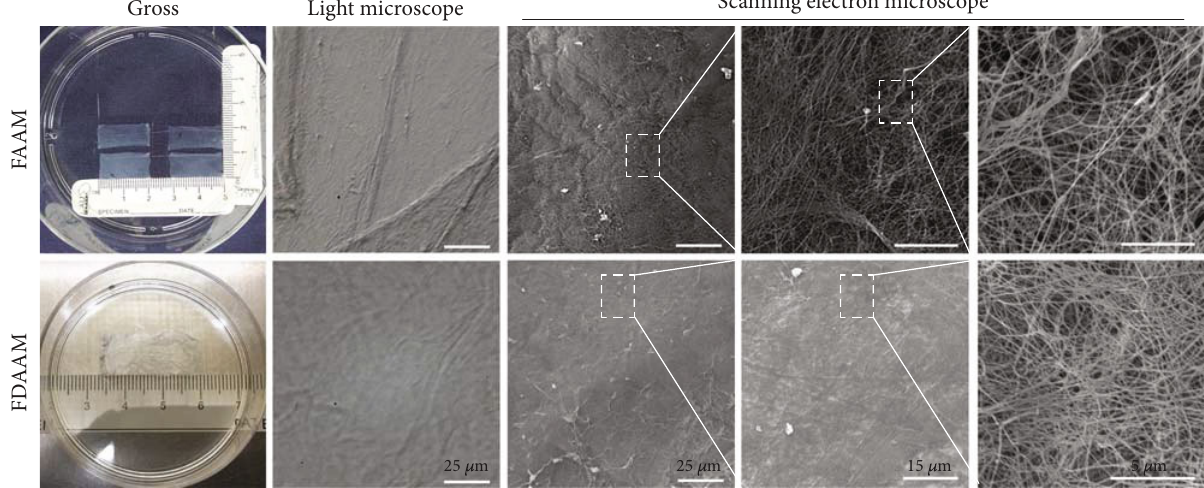
Figure 1: Morphology of FAAM and FDAAM. (a) Gross view, under light microscope and scanning electron microscope. Scale bars, 25 μ m, 15 μ m, and 5 μ m. FAAM: fresh acellular amniotic matrix; FDAAM: freeze-dried acellular amniotic